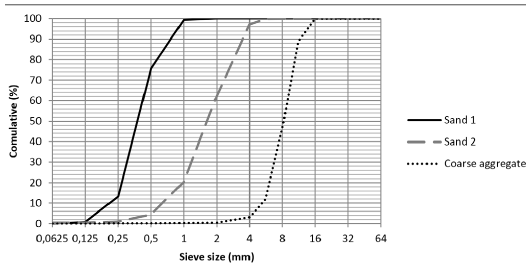
Figure 2. Grading of